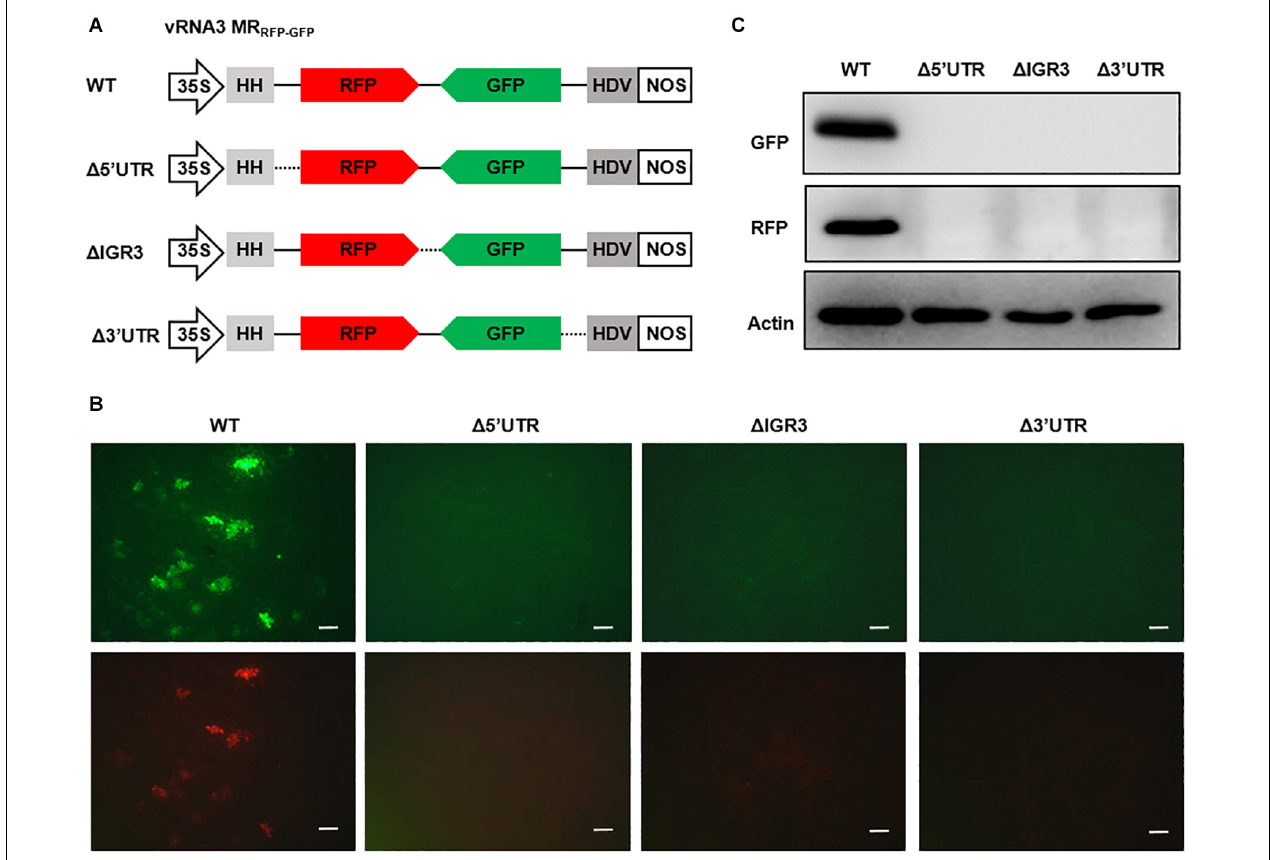
FIGURE 3 | Reverse genetics analysis of the roles of cis -elements in vRNA3 MR RFP − GFP reporter gene expression. (A) Schematic representations of vRNA3 MR RFP − GFP and its mutant derivatives. (cid:49) 5 (cid:48) untranslated region (UTR), (cid:49) 3 (cid:48) UTR, and (cid:49) IGR3 indicated the 5 (cid:48) or 3 (cid:48) untranslated regions, or the intergenic region were deleted in vRNA3 MR RFP − GFP , respectively. Solid lines denote viral non-coding regions, and dashed lines indicate the sequence regions being deleted. (B) GFP foci in N. benthamiana leaves agroinfiltrated to express the N, L-opt, VSR, and vRNA3 MR RFP − GFP or its mutant derivatives. Images were taken at 8 dpi with a fluorescence microscope. Scale bar = 200 µ m. (C) Protein gel blot analysis of GFP and RFP expression in agroinfiltrated leaf tissues. Blot was also probed with Actin-specific antibody to serve as a loading